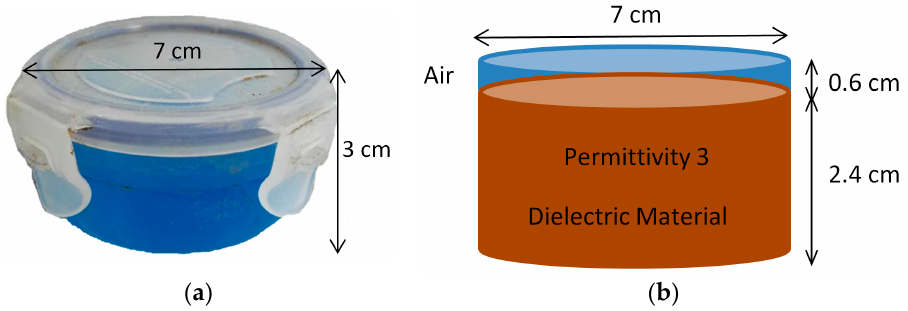
Figure 2. Object in the experiments: ( a ) Mine surrogate; ( b ) Object